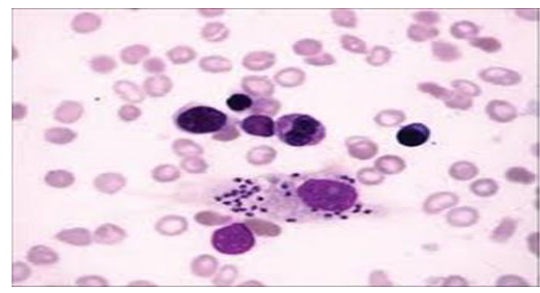
Figure 1. Amastigote of Leishmania t.major.